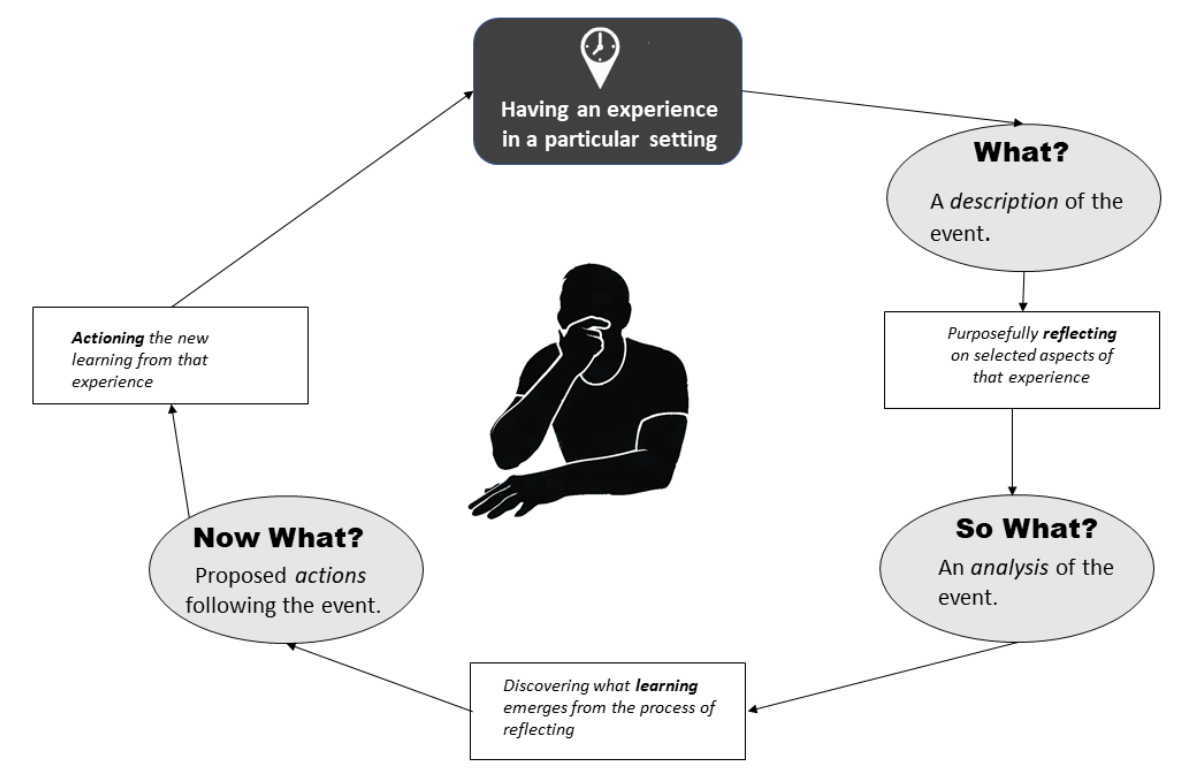
Figure 3. The What? Model of reflection - adapted from